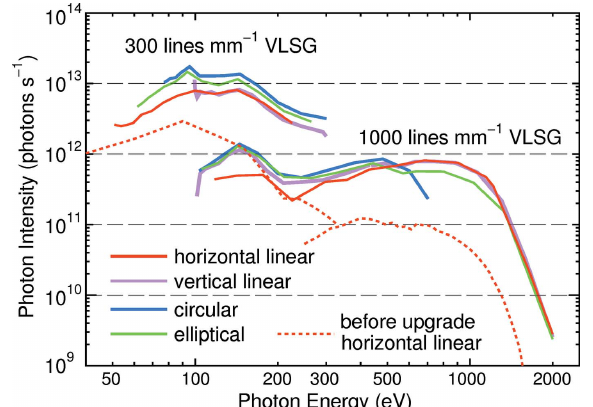
Figure 1 Photon intensity of BL-13A in the photon-energy region between 50 and 2000 eVafter installing the APPLE-II EPU. The photon intensities were converted to equivalent values for a ring current of 450 mA. The VLSGs with line densities of 300 and 1000 lines mm (cid:2) 1 cover photon energies between 48 and 300 eV and between 100 and 2000 eV, respectively. The photon intensity variation before the insertion-device upgrade is shown by dotted lines. The exit-slit width was 100 m